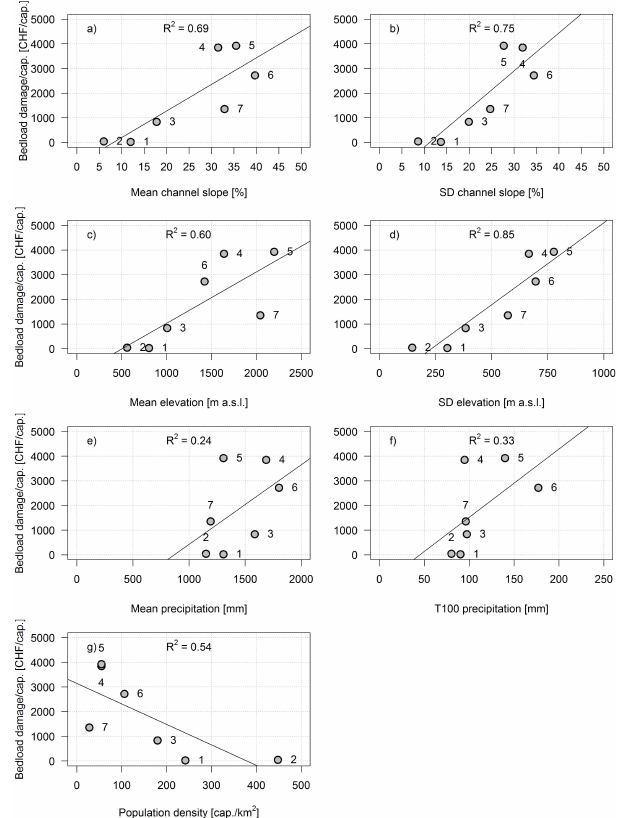
Fig. 8. Relation, for the seven different subareas, between the cu- mulative bedload damage costs per capita and (a) the mean/ (b) stan- dard deviation of channel slope, (c) the mean/ (d) standard deviation of elevation, (e) the mean annual precipitation, (f) the 1-day rainfall with a recurrence interval of 100yr, and (g) the population density. Note that the average of the lower and upper estimates was applied to determine the damage costs per capita. Numbers next to the data points denote subareas according to Table 1 and Fig.